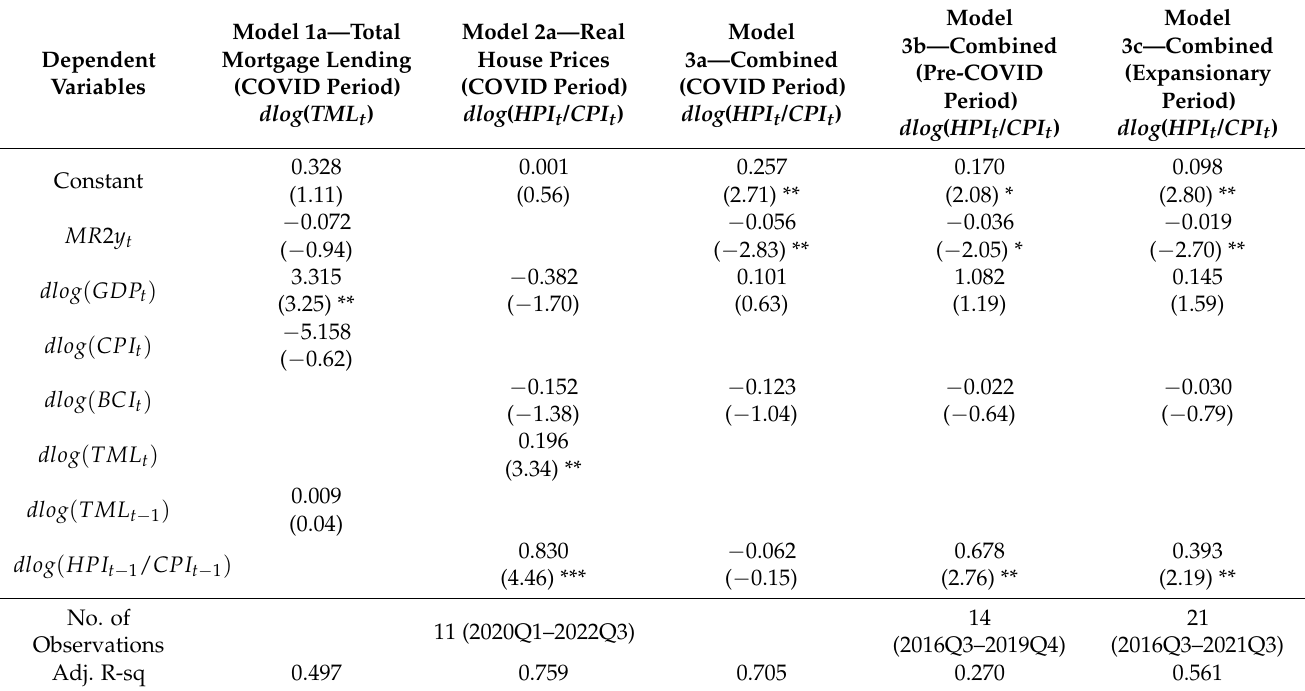
Table 4. Results of the robustness